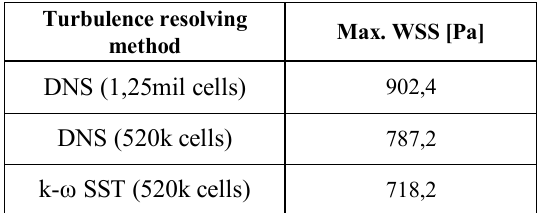
Table 1. Maximum values of Wall Shear Stress (WSS) achieved during the moment of the highest flow rate.